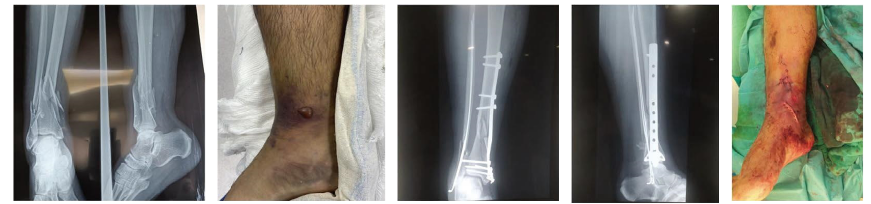
Figure 1: Pre- and postoperative clinical and radiographic images of a 33-year-old patient treated with